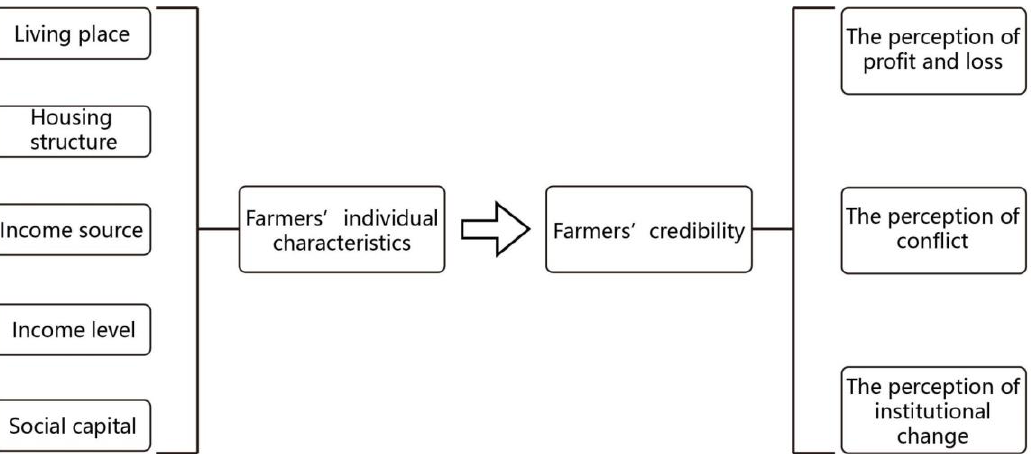
Figure 1. How farmers’ individual characteristics affect the credibility of policies.